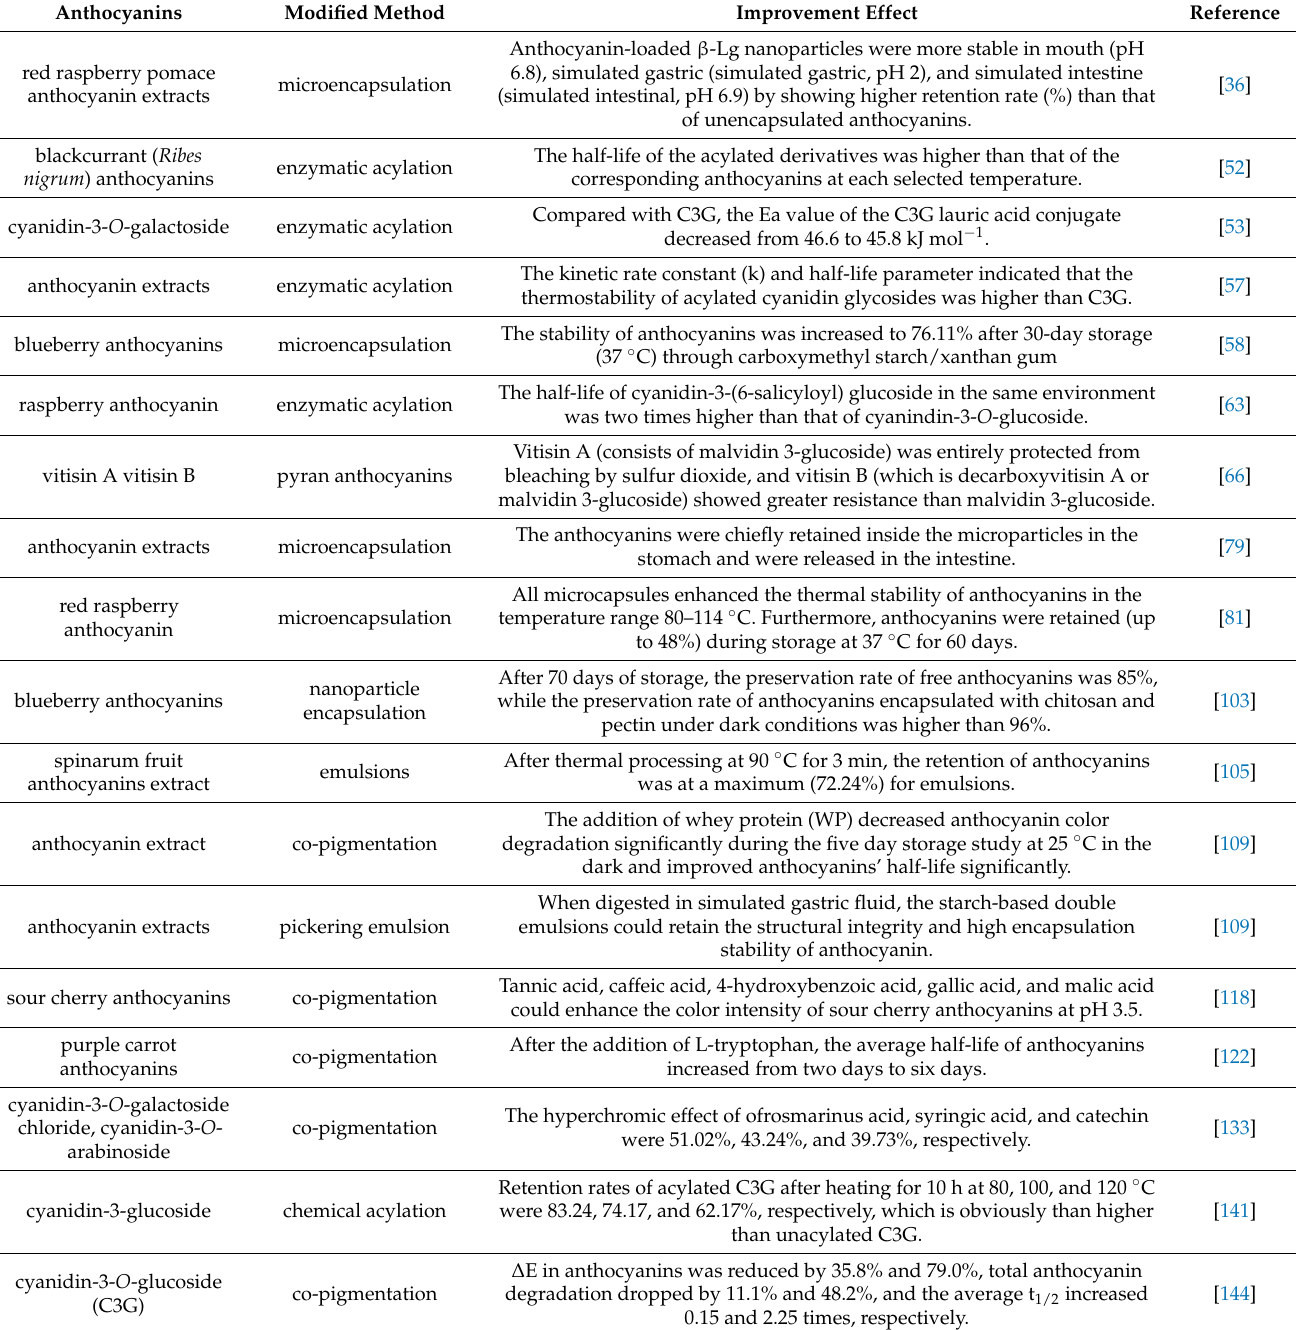
Table 5. Stability performances of modified